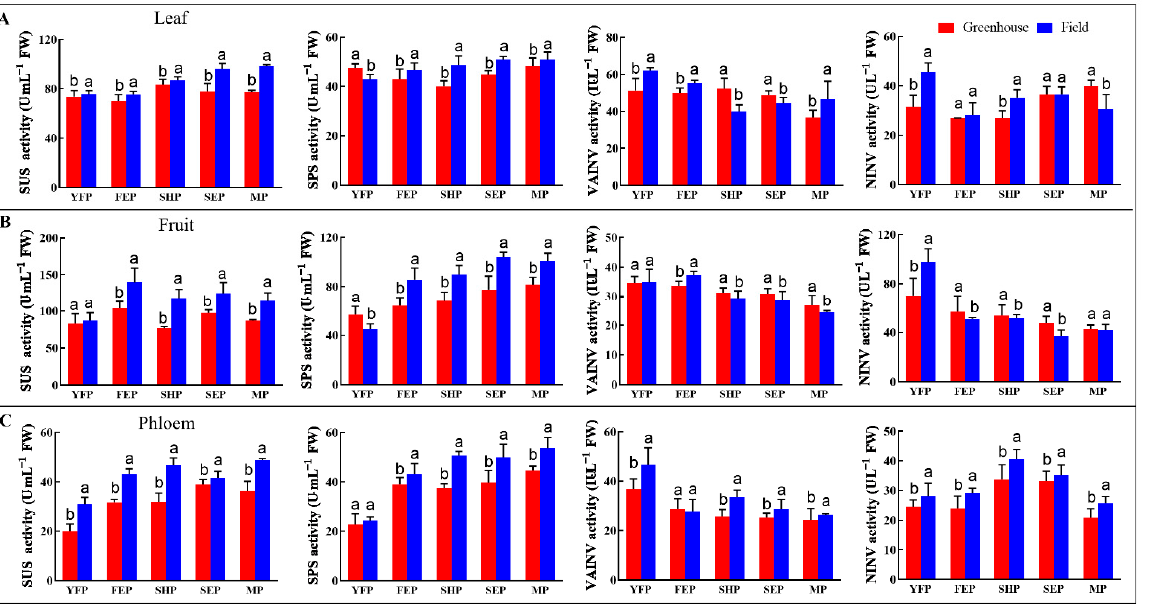
Figure 4. Activities of enzymes related to sucrose metabolism in different parts of peach trees grown in the field and greenhouse. ( A – C ) show the activities of sucrose metabolic enzymes in leaves, fruits and phloem, respectively. These enzymes include SUS, SPS, VAINV and NINV. The data are presented as the means ± SDs from three biological replicates. Different lowercase letters indicate significant differences ( p < 0.05).